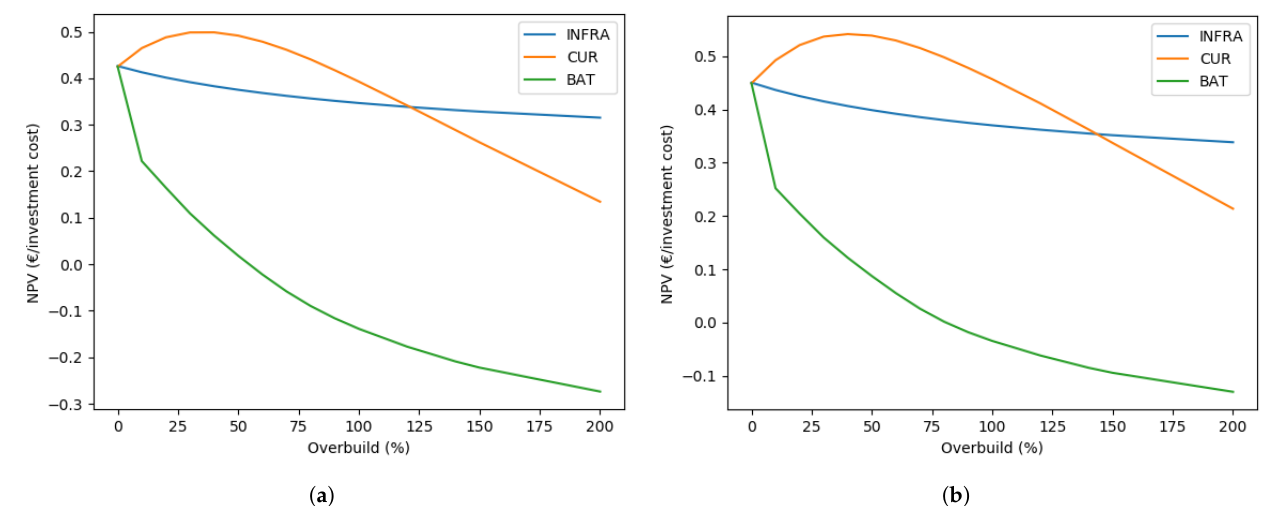
Figure 4. NPV using ( a ) SDE+ and ( b ) 2030 prices for the different